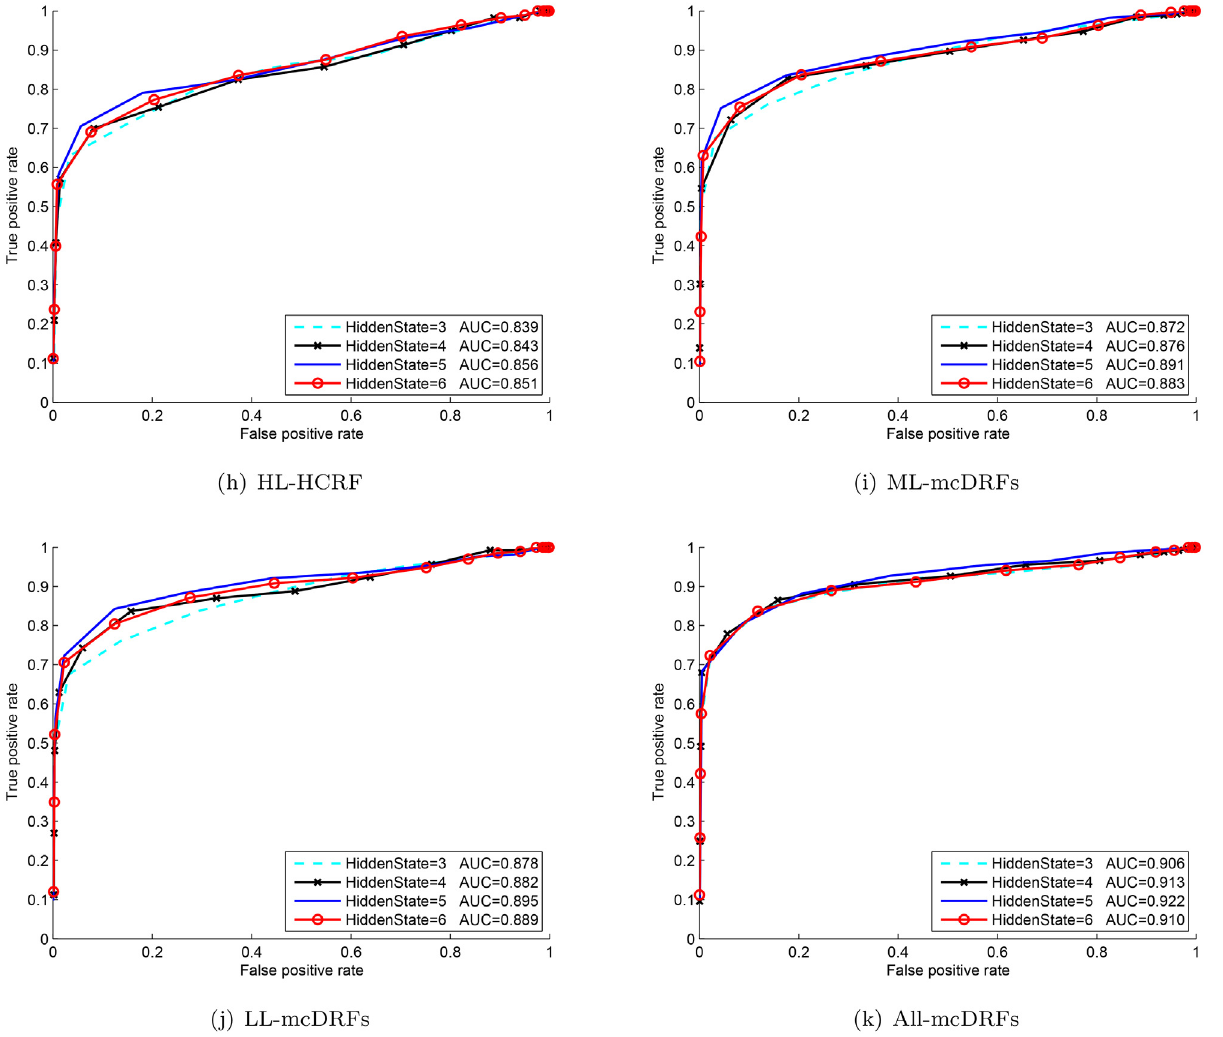
Fig 5. ROC and AUC of TJU with different hidden